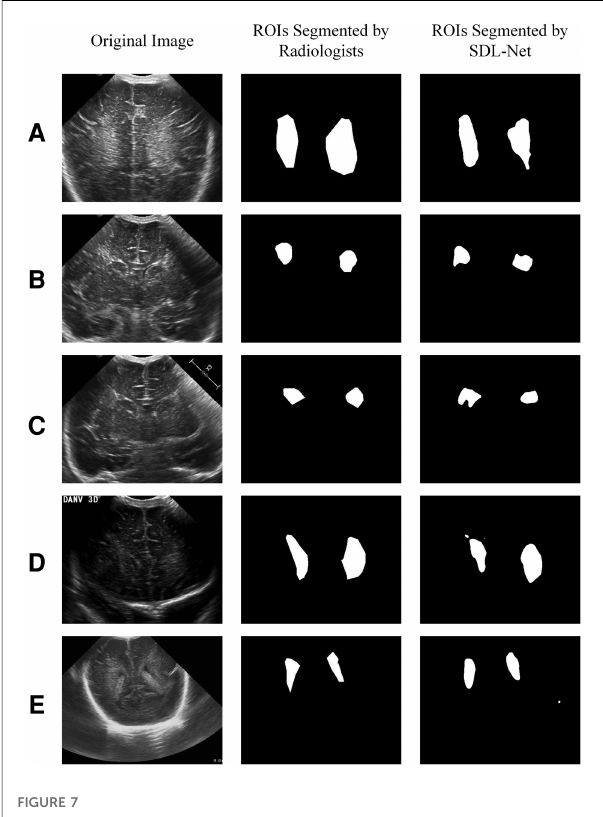
FIGURE 7 White matter ROIs segmented by SDL-Net.